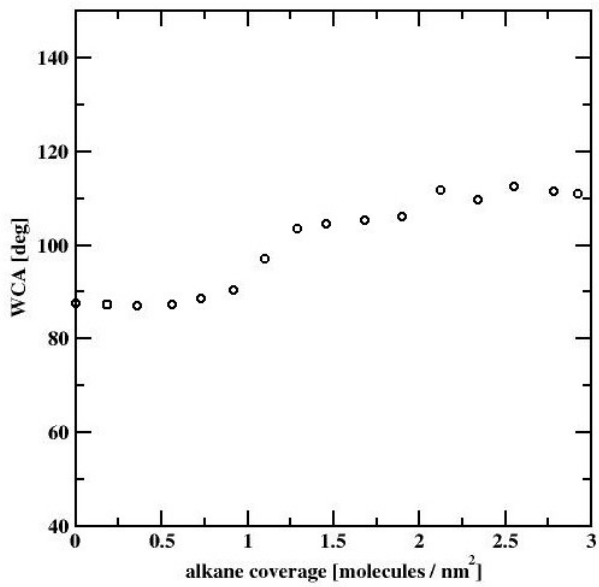
Figure 10. WCA dependence on hydrocarbon surface coverage, for water nanodroplets on n-decane- covered bare silicon